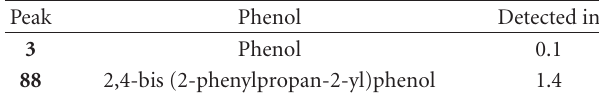
Table 8: Phenols detected in the products from ASF ODVR